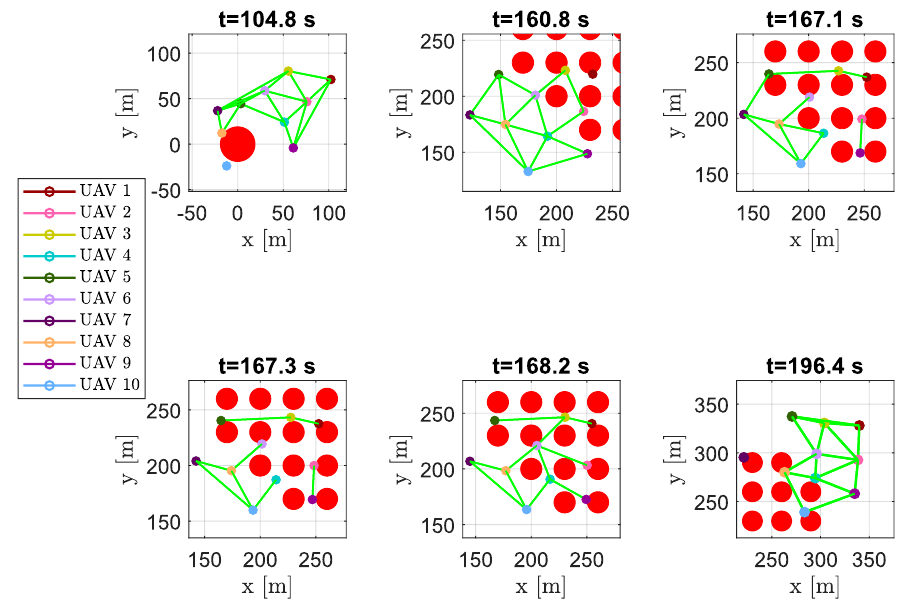
Figure 26. Scenario #3—10 aircraft: snapshots of UAV positions at different time instants. Colored markers indicate UAVs’ actual positions, straight green lines show the DTG arcs. Snapshots highlight how the DTG connectivity rapidly changes in presence of obstacles.